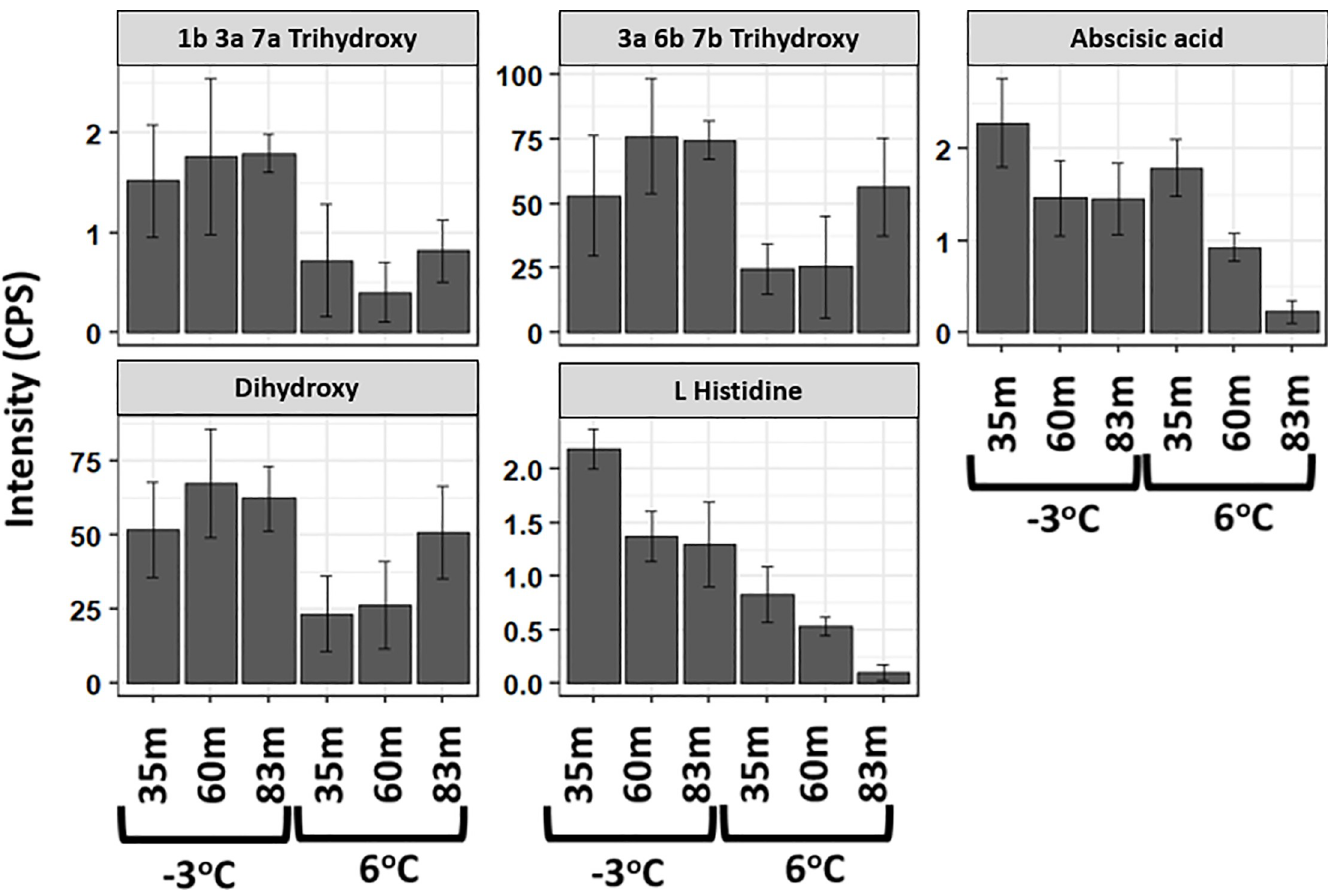
Fig 7. A bar chart of the important metabolites driving discrimination groups in the PCA scores with their respective standard error over three replicates in the ESI- mode. Important metabolites were identified as the top 10% of the PCA loadings in the filtered dataset. Metabolites “1b 3a 7a Trihydroxy”, “3a 6b 7b Trihydroxy”, and “Dihydroxy” were abbreviated for “1b 3a 7a Trihydroxy 5b cholan 24 oic acid”, “3a 6b 7b Trihydroxy 5b cholan 24 oic acid”, and “3alpha 12beta Dihydroxy 5beta cholan 24 oic acid”, respectively.